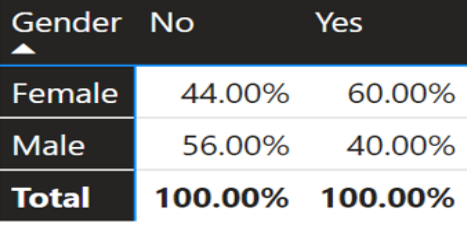
Fig. 2. Increase in Performance Pressure